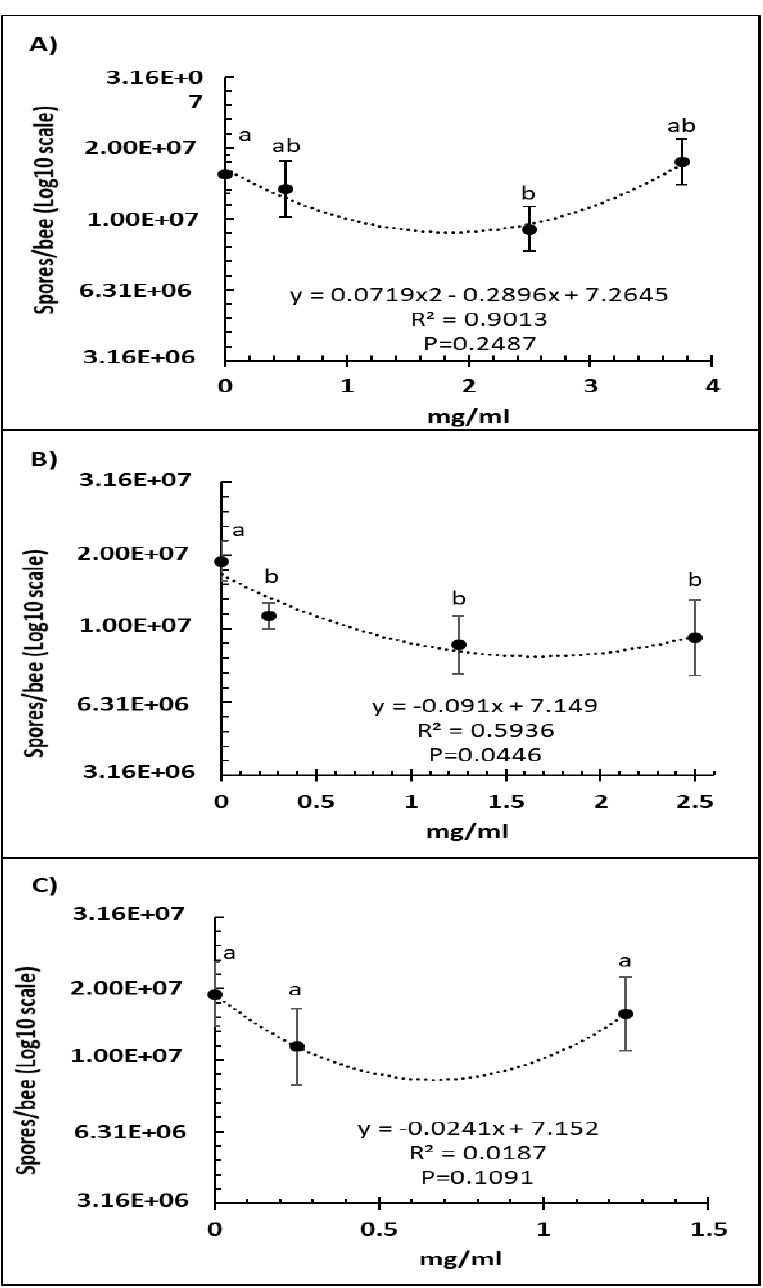
Figure 1. Relationship between N. ceranae spore count (Log10) and concentration (mg/mL) of the probiotics Vetafarm Probotic ( A ), Protexin Concentrate single-strain ( B ), and Protexin Concentrate multi-strain ( C ), fed to N. ceranae -infected honey bees. Treatments followed by the same letter are not significantly different.